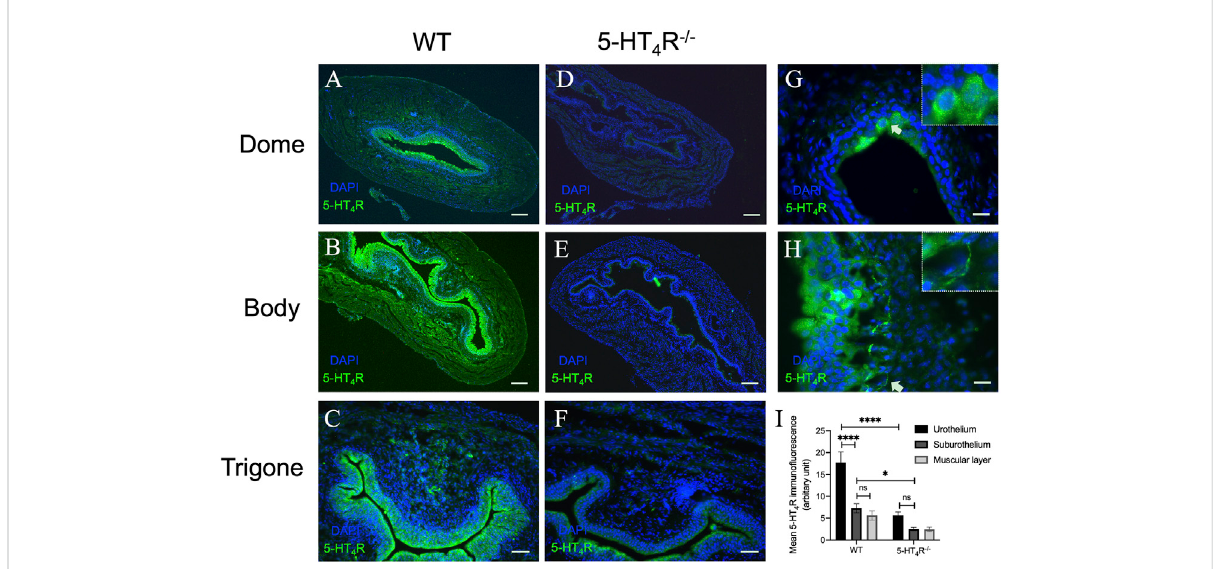
FIGURE 1 Representative microphotographs of 5-HT 4 R immuno fl uorescence in murine bladder in WT and 5-HT 4 R − / − mice. All panels are stained with 5- HT 4 R(green)and nucleiare stainedbyDAPI(blue).5-HT 4 Rimmuno fl uorescence stainingatDome (A) ,Body (B) andTrigone (C) ofthebladderinWT mice.Speci fi cityofantibodyfor5-HT 4 Rwascon fi rmedbydiminishedimmuno fl uorescencein5-HT 4 R − / − mice (D – F) . (G,H) High-magni fi cationview of 5-HT 4 R immuno fl uorescence in WT bladder wall. Arrows indicate strong 5-HT 4 R immunoreactivity in a population of epithelial cells and nerve fi bers in subepithelial layer. (I) Quantitative analysis of the expression of 5-HT 4 R in different layers of bladder in WT and 5-HT 4 R − / − mice (Two- way ANOVA, n = 6 tissue sections from two mice for each group). Calibration bars, 200 μ m in (ABDE) , 50 μ m in (CF) , 25 μ m in (GH)